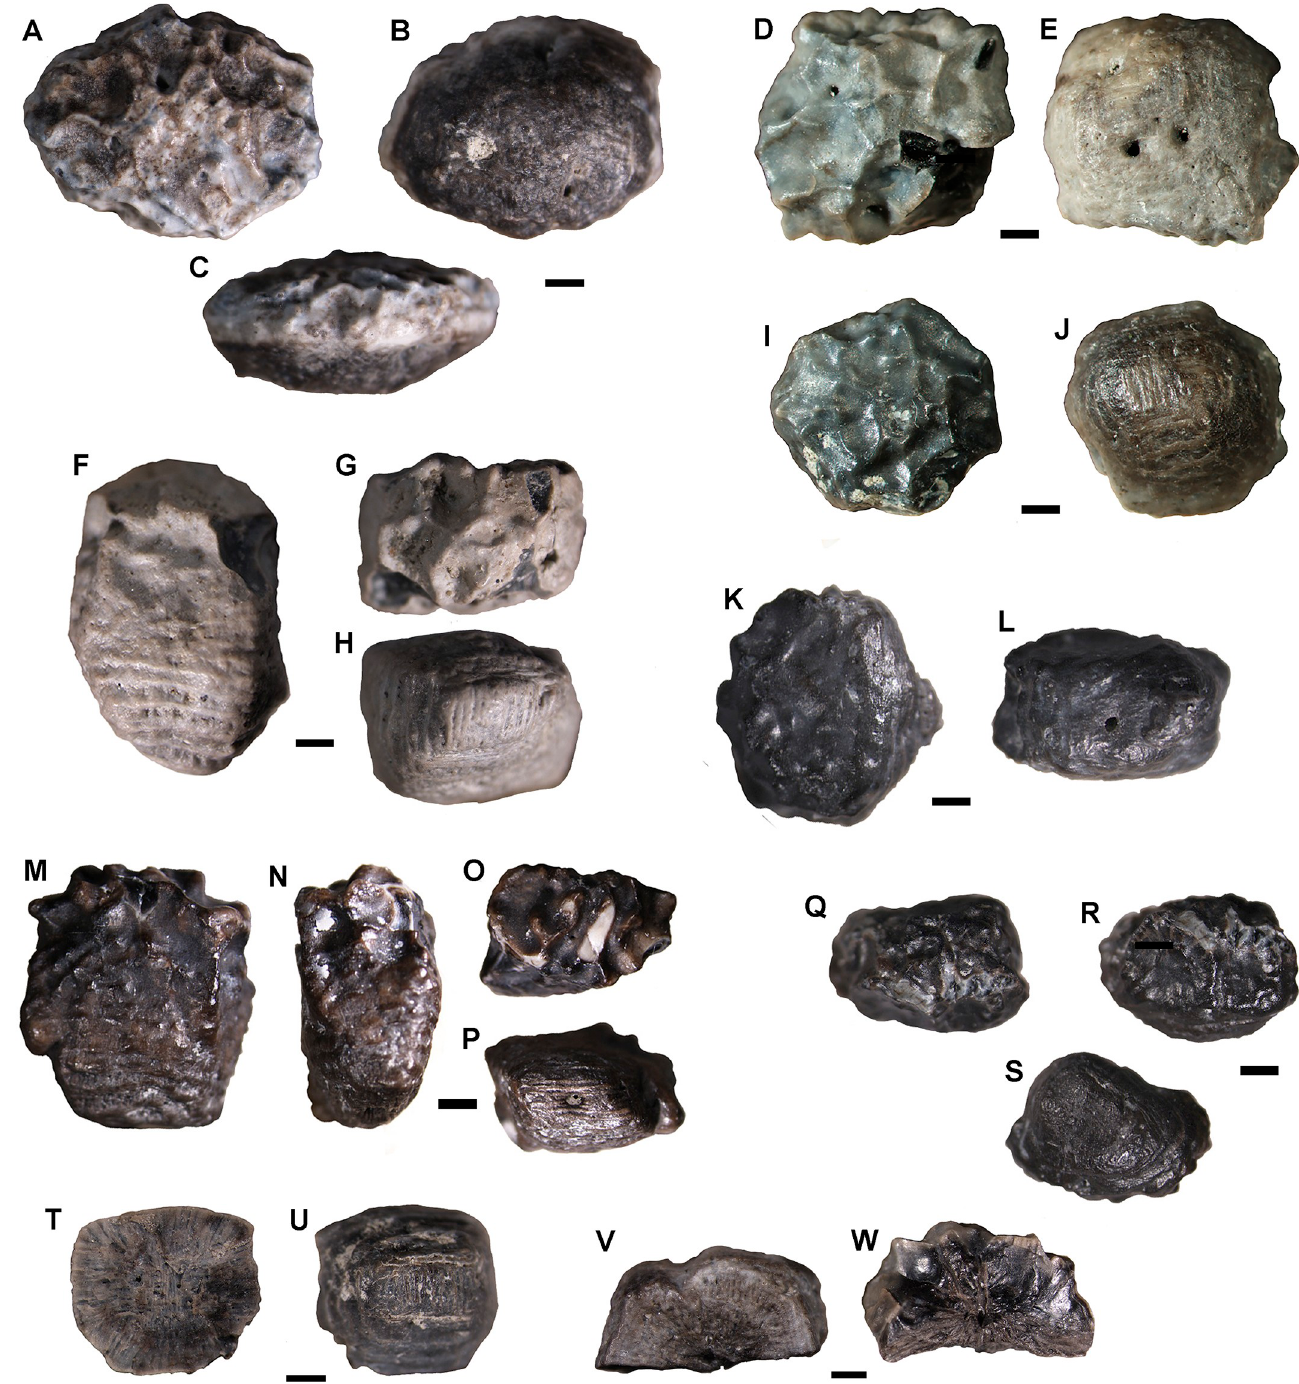
Fig 3. Ankylosaur interstitial ossicles (osteoderms) in superficial, internal and lateral views. MPM-PV-18805.14 (A-C), MPM-PV-18805.15 (D-E), MPM-PV- 18805.16 (F-H), MPM-PV-18805.17 (I-J), MPM-PV-18805.18 (K-L), MPM-PV-18805.19 (M-P), MPM-PV-18805.20 (Q-S), MPM-PV-18805.21 (T-U), MPM-PV- 18805.22 (V-W). Scale bars =